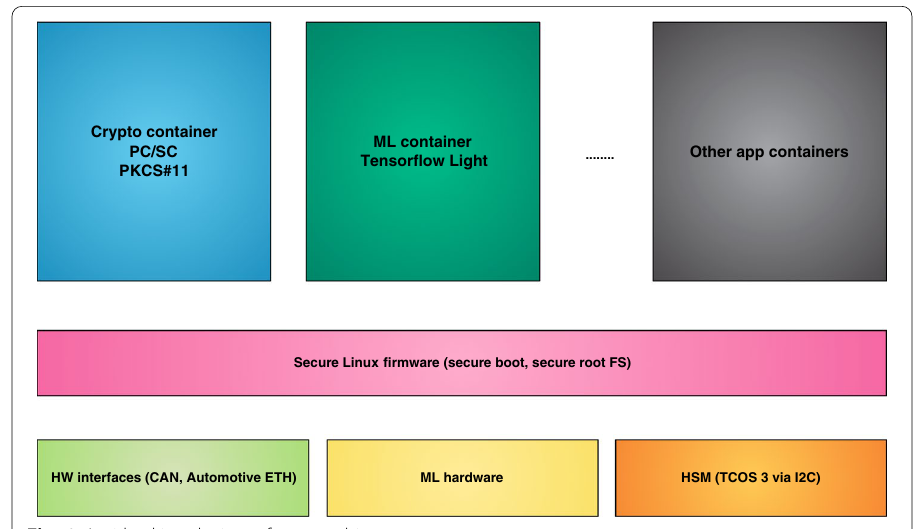
Fig. 6 Anti‑hacking device software